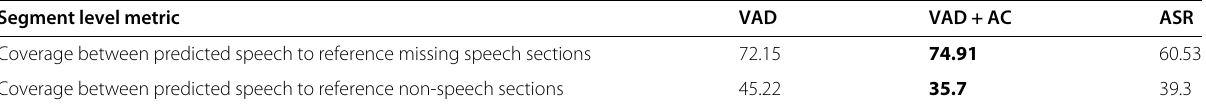
Table 5 Analysis on human annotated dataset Segment level